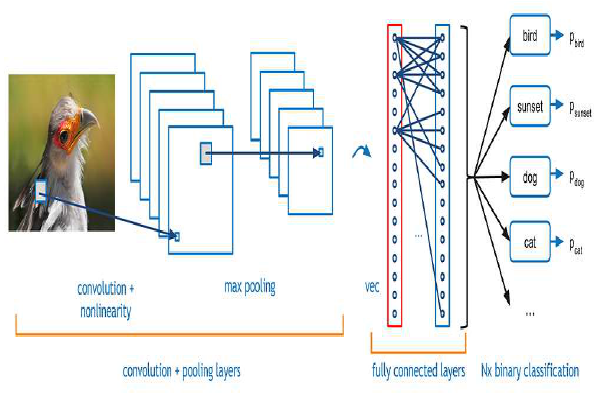
Figure 1. Working of Convolution Neural Network